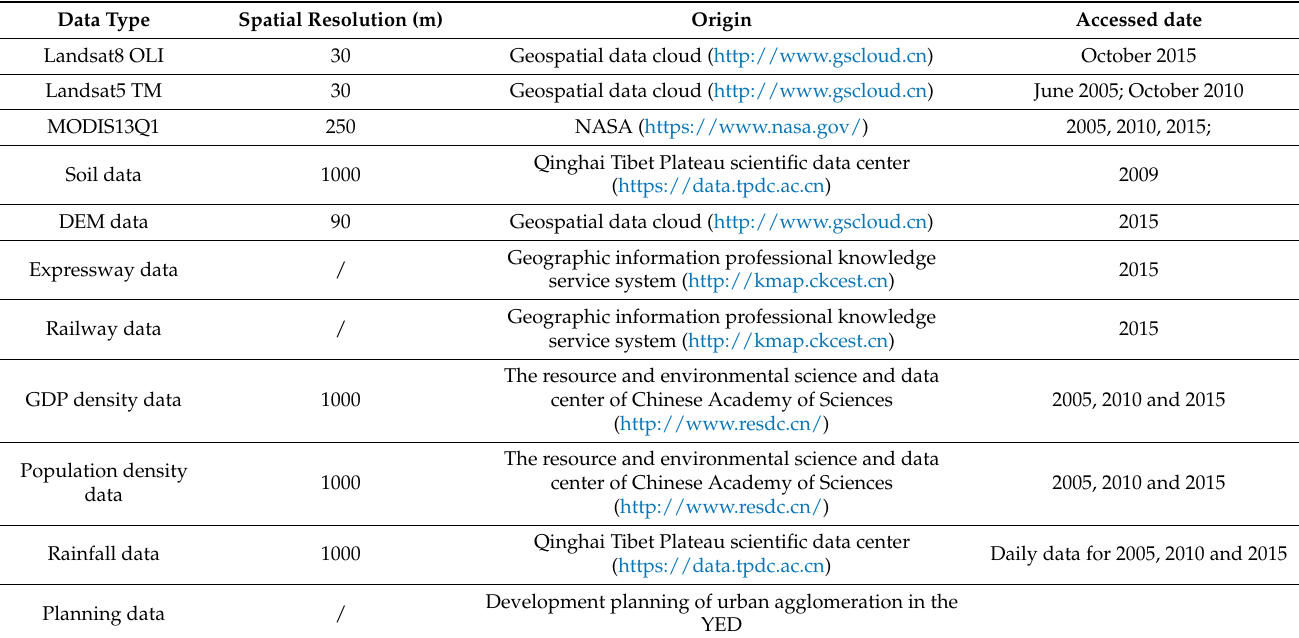
Table 1. The data used in the study.